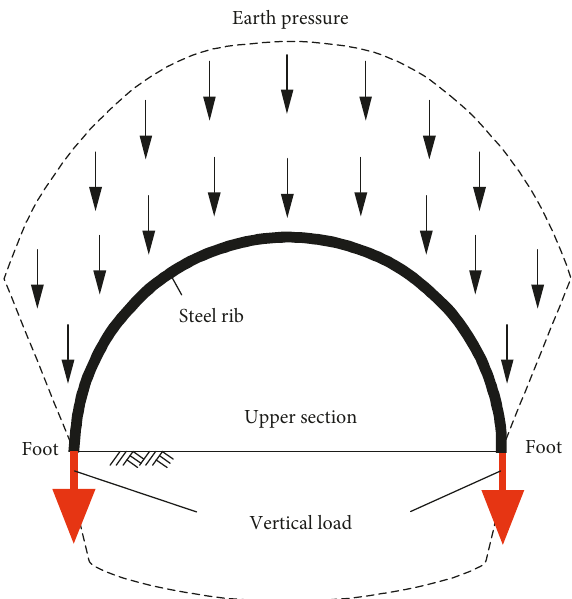
Figure 1: Steel ribs without the support of the feet-lock pipe.